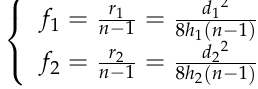
Where, R , f and F# are parameters of the microlens array, according to which the structural parameters ( D and H ) of cylinders before melting can be calculated. f is the focal length of the microlens, and F# is the F number. Then, the mask patterns can be designed, and the version as well as the thickness of the photoresist can be determined.